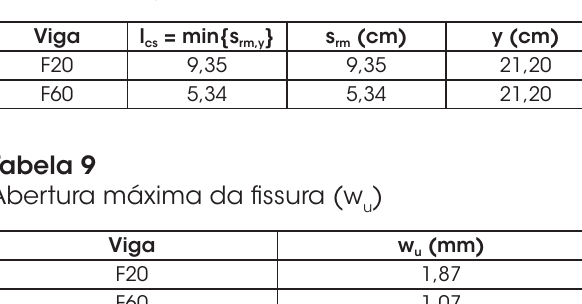
Diagramas de deformações e tensões para determinação do comprimento característico (l de concreto armado reforçadas com fibras (MC